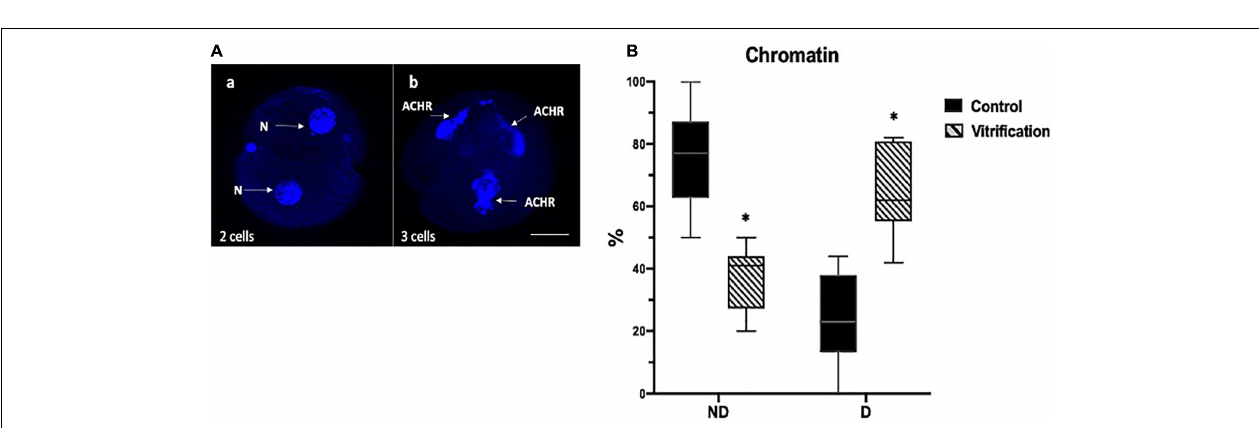
FIGURE 5 | Evaluation of actin microfilaments (MF) in early embryos by phalloidin-fluorescein isothiocyanate (FITC) staining in the control and vitrified groups; (A) representative images for actin microfilament evaluation criteria in early ED: (a) white arrows show cortical actin (CA); (b) white star shows dispersed actin (DA), and (c) white star shows dispersed cortical actin (DCA); the total numbers of evaluated cells in the control and vitrification groups were 61 and 35, respectively; 200 × , scale bar = 30 µ m; (B) percentage of actin microfilaments in early ED. ∗ Indicate significant difference vs. control. P < 0.05.